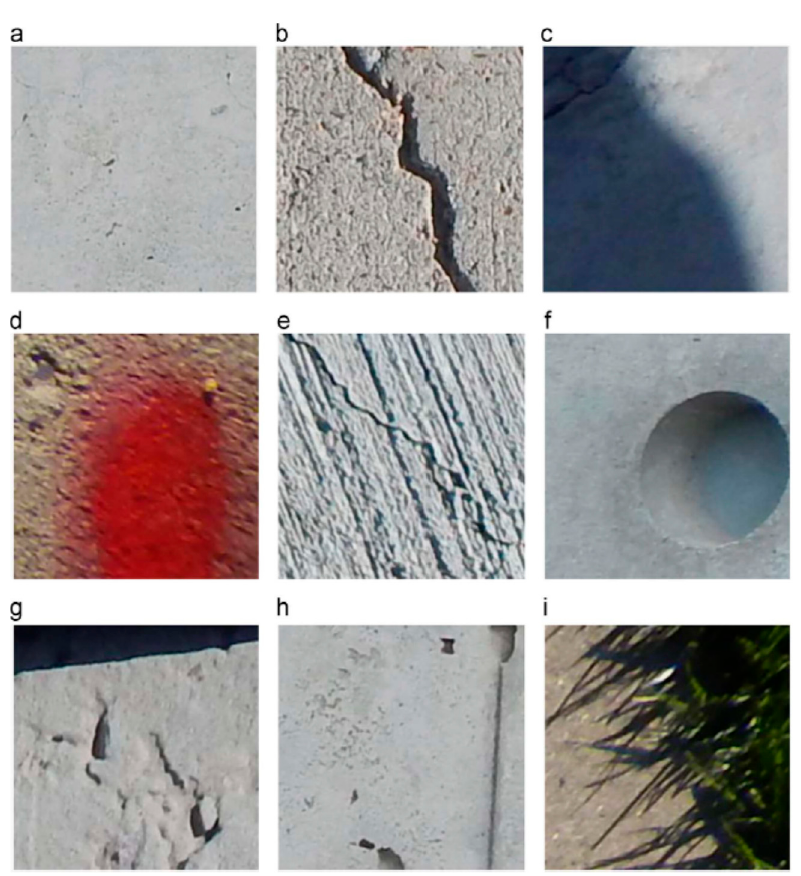
Figure 17. NDT Scalogram.